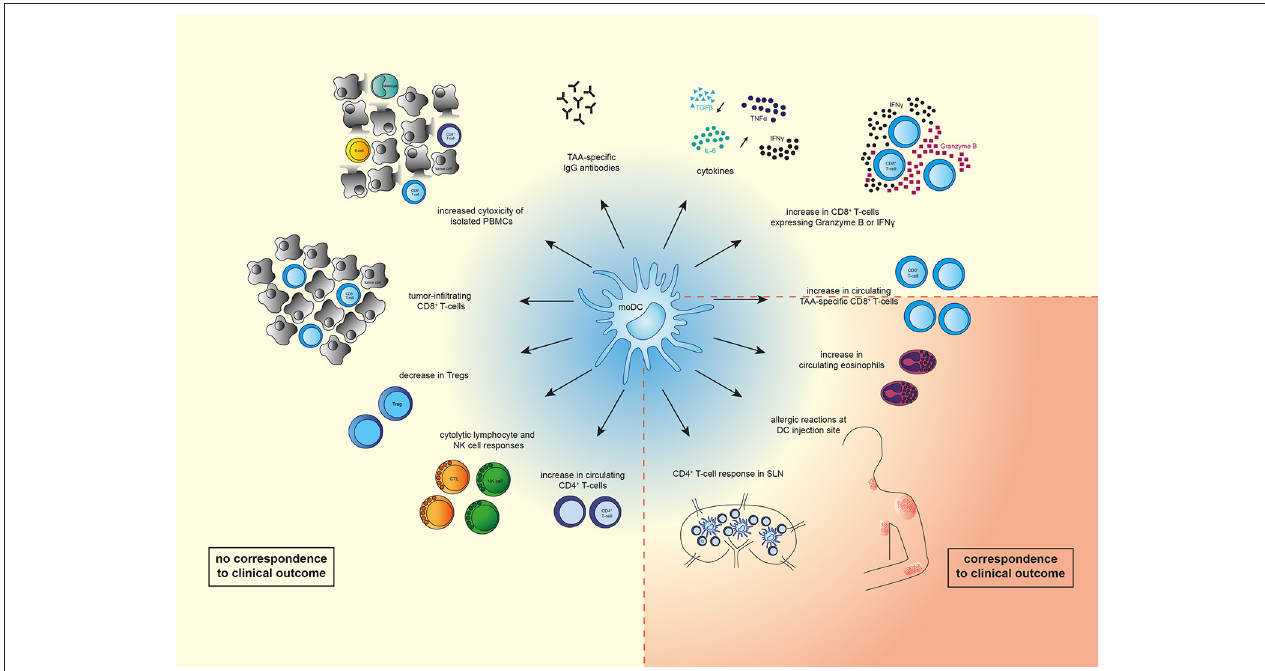
FIGURE 1 | Overview of immunological changes observed upon moDC therapy. Vaccination with moDCs can lead to various immunological changes such as an increase in numbers of circulating immune cells (TAA-specific CD8 + T-cells, CD8 + T-cells expressing IFN γ or Granzyme B, CD4 + T-cells, eosinophils), or a decrease of other immune cells (Tregs). In addition, systemic cytolytic lymphocyte (CTL) or natural killer (NK) cell responses, as well as CD4 + T-cell responses in sentinel lymph nodes (LNs) were observed. Levels of TAA-specific IgG antibodies and cytokines (IL-6, IFN γ , TNF α ) increased, whereas levels of TGF β decreased. Vaccination with moDCs also resulted in tumor-infiltrating CD8 + T-cells, increased cytotoxicity of isolated PBMCs (monocytes, CD8 + and CD4 + T-cells, B-cells), and allergic reactions at the DC injection site. Of the shown changes, only increased circulating TAA-specific CD8 + T-cells, eosinophilic blood count, strength of allergic reactions at DC injection site, and a CD4 + T-cell response in sentinel LNs correspond to clinical